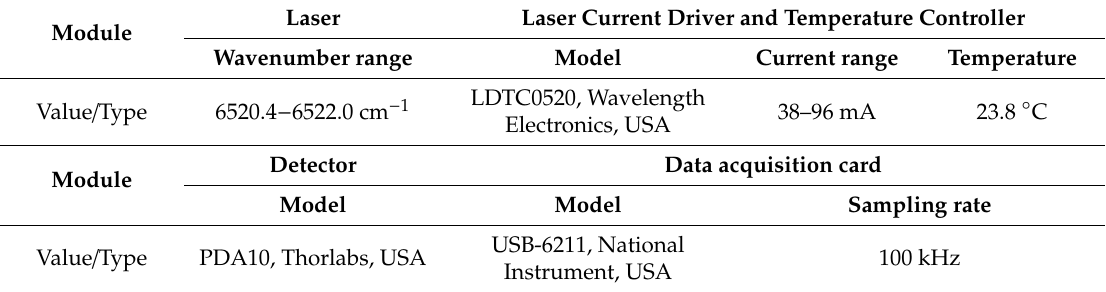
Table 3. The parameters and models of the key modules used in the sensor system.